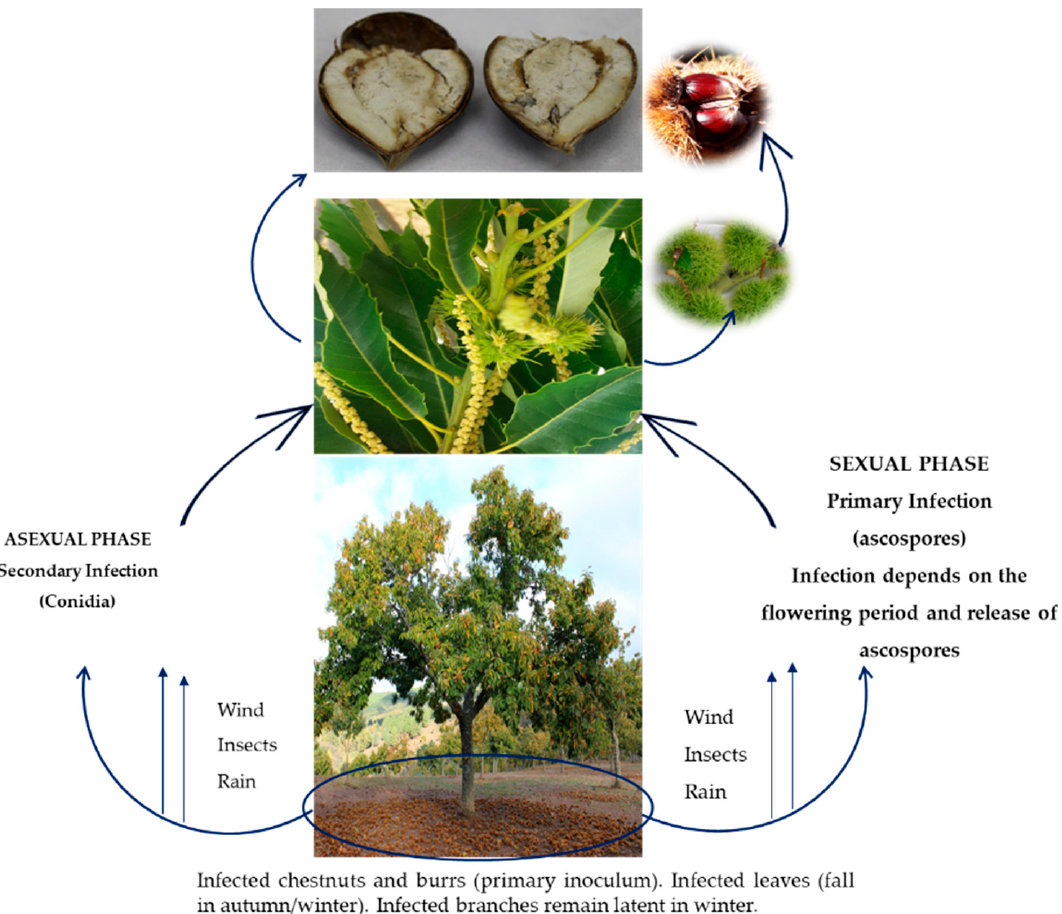
Figure 1. Process of infection of the fungus Gnomoniopsis smithogilvyi . Source: Adapted from Shuttleworth and Guest [37].